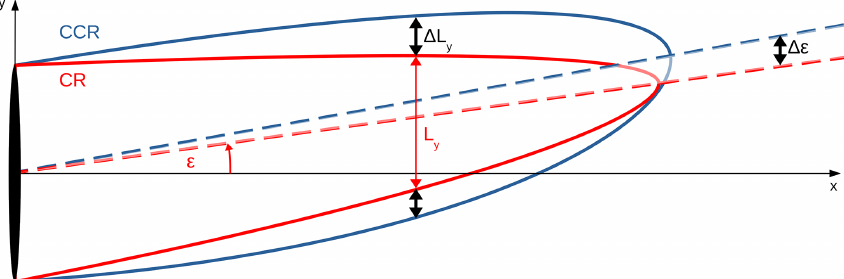
Figure 20. Schematic illustration of the difference in the spanwise wake width ( L y ) and the wake deflection angle ( (cid:15) ) between clockwise- rotating CR and counterclockwise-rotating CCR actuators. The parameter impact on these wake differences is represented by (cid:49)L y and (cid:49)(cid:15) . The differences in (cid:49)L y are valid over the whole rotor, whereas (cid:15) = (cid:49)(cid:15) = 0 at hub height as v f ( z h ) = 0 (Eq.